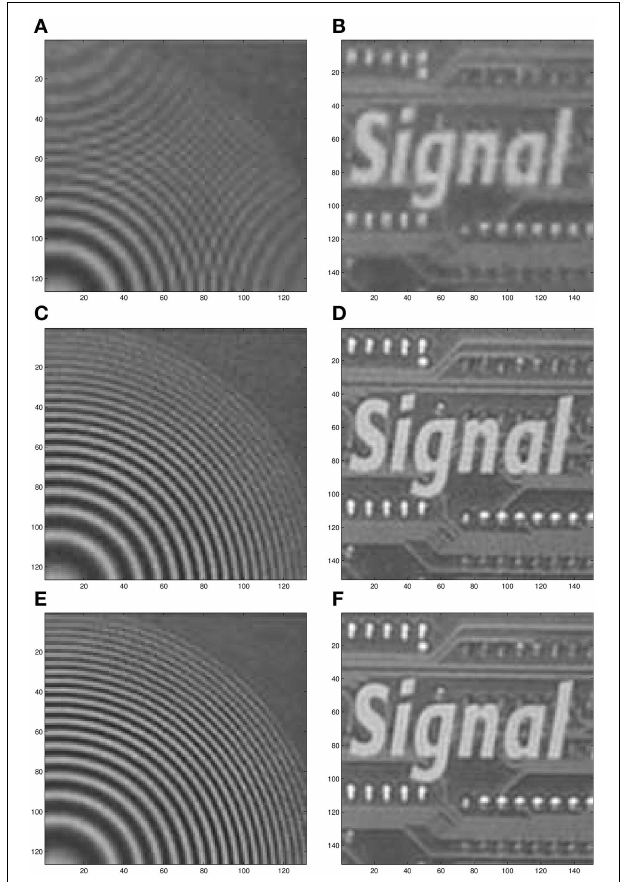
FIGURE 15 | Two processed ROIs from the real image sequence (data set I). Bicubic output for ROI 1 (A) and ROI 2 (B) . AWF SR output for ROI 1 (C) and ROI 2 (D) . CAWF SR output for ROI 1 (E) and ROI 2 (F)